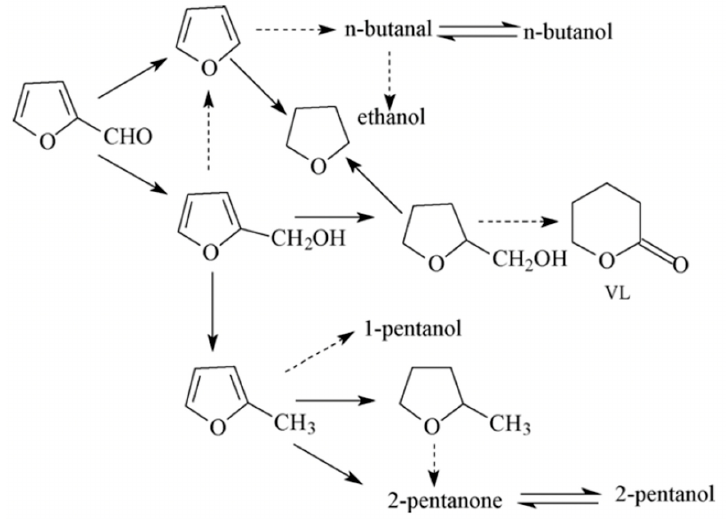
Figure 13. HDO pathways of furfural. Reprinted from reference [89].